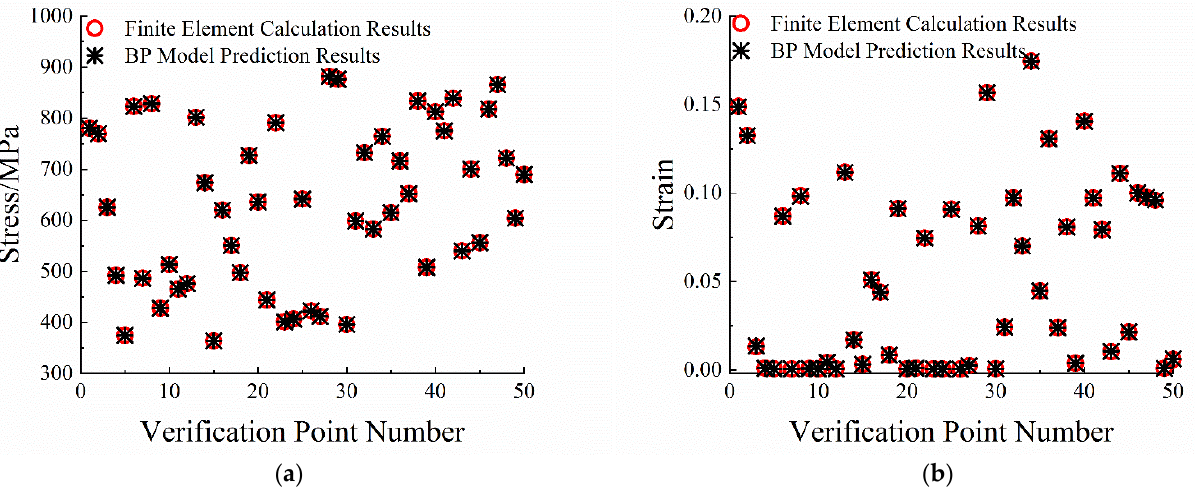
Figure 9. Mapping model validation: ( a ) stress model validation; ( b ) strain model validation.